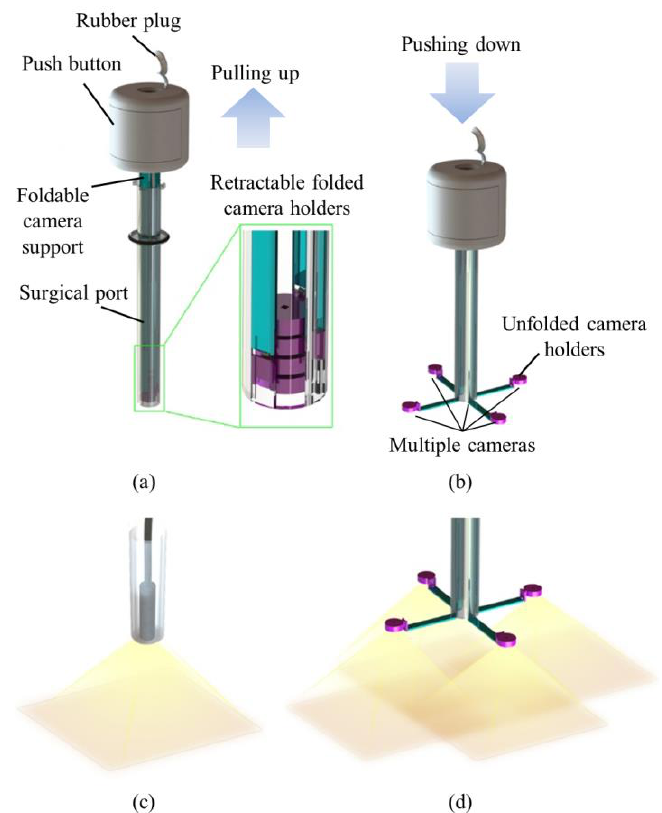
Figure 1. Design and concept of a trocar-camera assembly (TCA). The TCA consists of a push button, foldable camera supports, a surgical port, and miniaturized cameras. ( a ) The miniaturized cameras are stacked within the surgical port when the port is inserted into or extracted from a simulator box. ( b ) Miniaturized cameras are deployed after the surgical port is inserted into the simulator box. Surgical instruments can be inserted through the port because the port is not occupied by the cameras during operation. ( c ) Small field-of-view (FoV) of the current laparoscopic camera. ( d ) Large FoV provided by the multiple cameras.